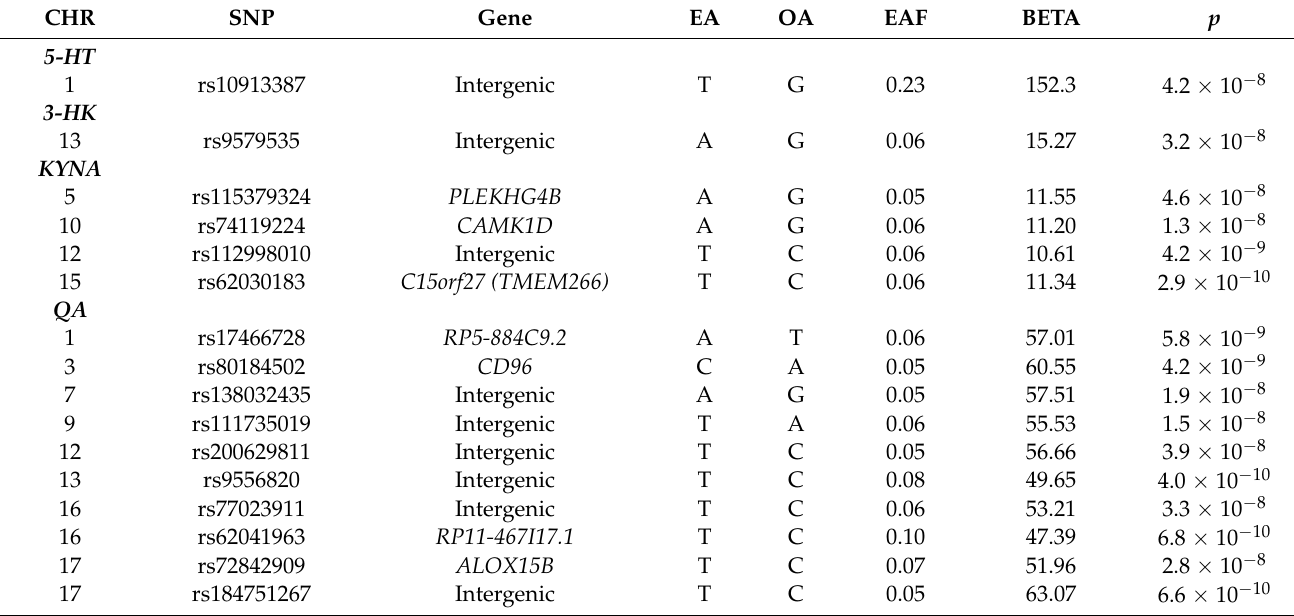
Table 3. SNPs associated with metabolite levels with no significant effect of